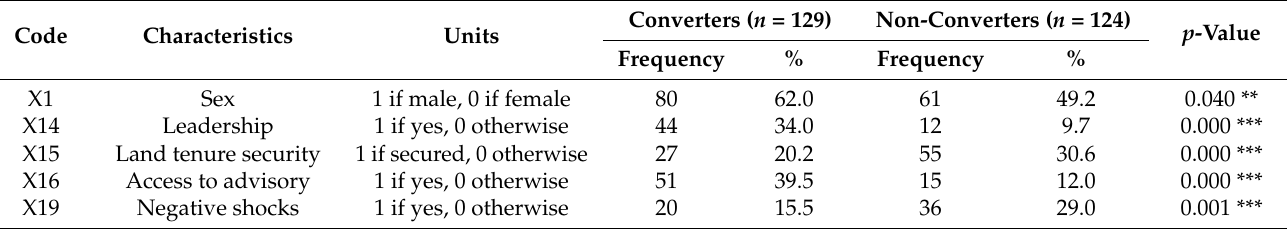
Table 5. Descriptive statistics for respondents’ characteristics: Binary variables.